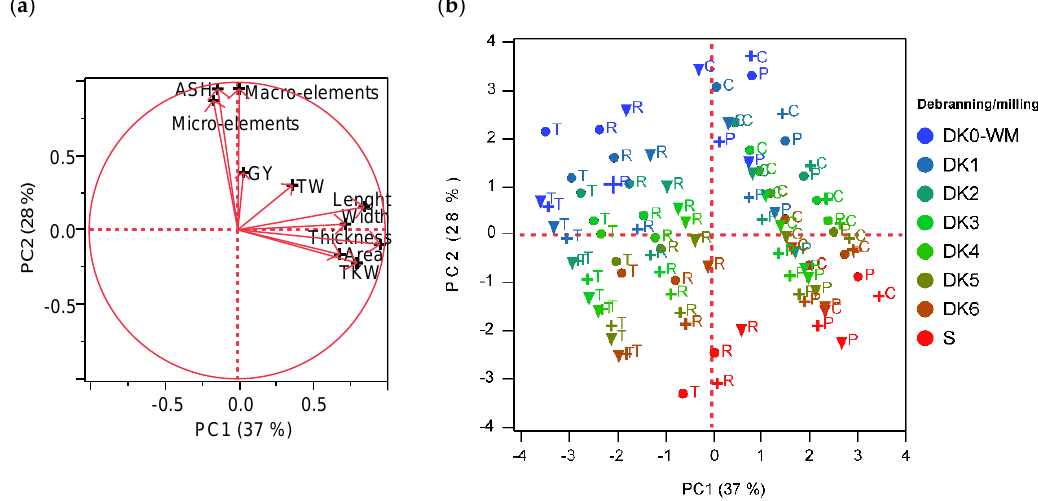
Figure 2. PCA loading plot showing the distribution of the analyzed variables ( a ) and score plot ( b ) showing the distribution of old genotypes (C = Cappelli, P = Perciasacchi, R = Russello, T = Timilia), grown in the three environments (● Palermo, + Foggia, ▼ Agrigento) during processing (milling/debranning from blue to red: DK0-WM (wholemeal), DK1, DK2, DK3, DK4, DK5, DK6, S (semolina)) along the two principal factors. (For interpretation of the references to color in this figure legend, the reader is referred to the web version of this article). Macro-elements = sum of Na, K, P, Ca, and Mg; micro-elements = sum of Mn, Fe, Cu, Zn and Mo; GY = grain yield; TW = Test Weight; TKW = Thousand kernel weight; PCA = Principal component analysis.